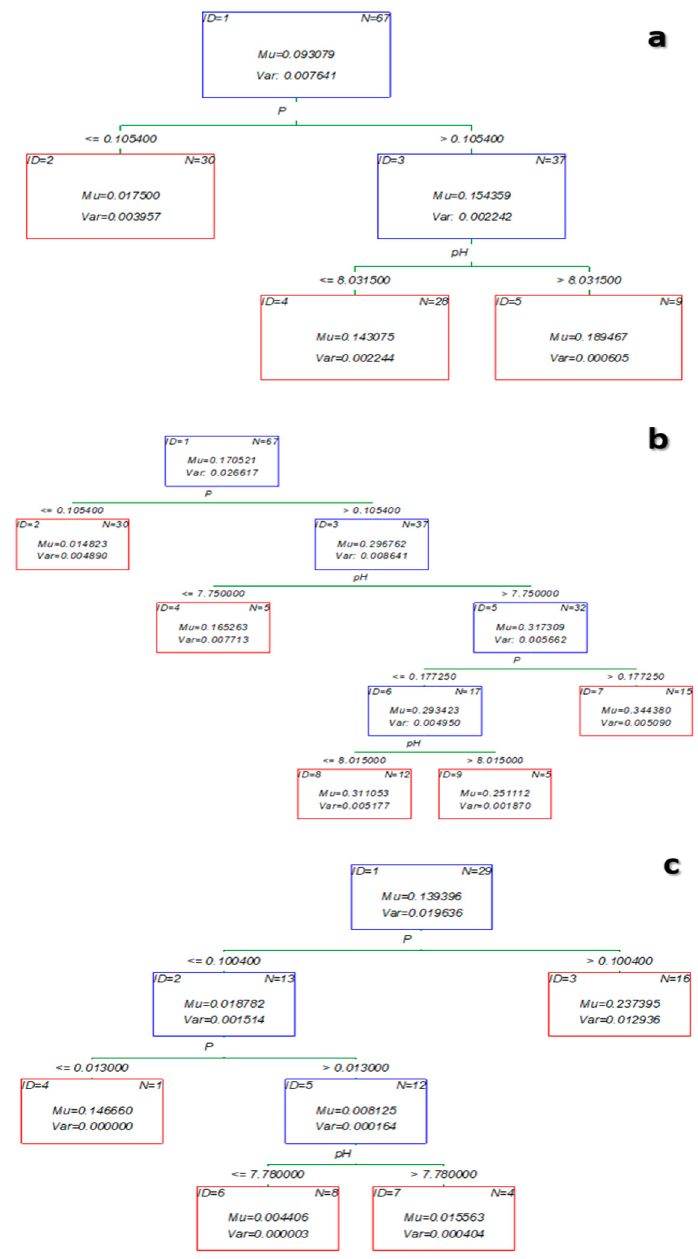
Figure 8. Boosted regression tree graph of Co ( a ), Cu ( b ) and Pb ( c ) ( Mu , mean; Var , variance).